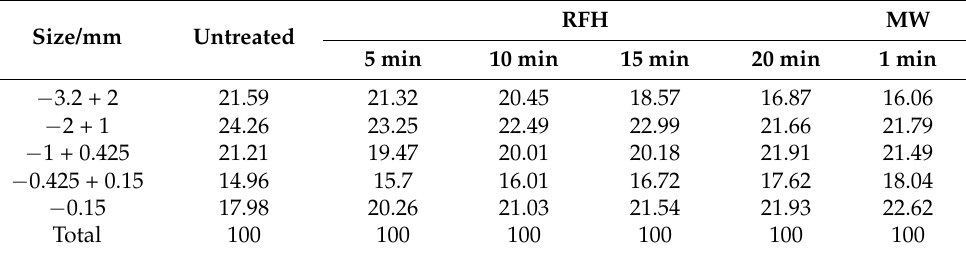
Table 6. Effect of traditional heating time with water cooling on the particle size distribution of the grinding product.